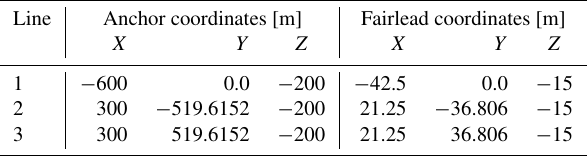
Table 7. Activefloat’s mooring lines